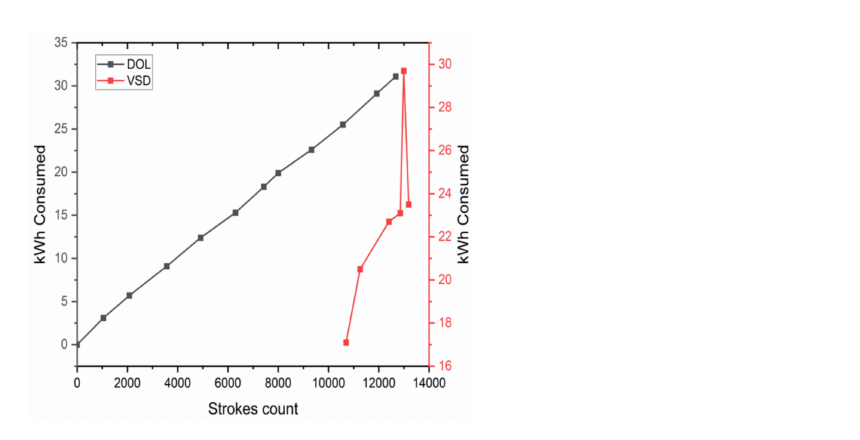
Figure 6. Electrical energy consumption variation with press strokes in VSD control.